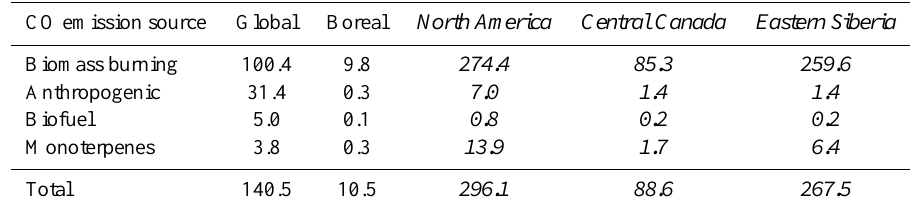
Table 2. Total CO emissions over the BORTAS-A campaign period (12 July to 4 August 2010) in units of Tg C. Values in italics have units of 10 − 3 TgC.